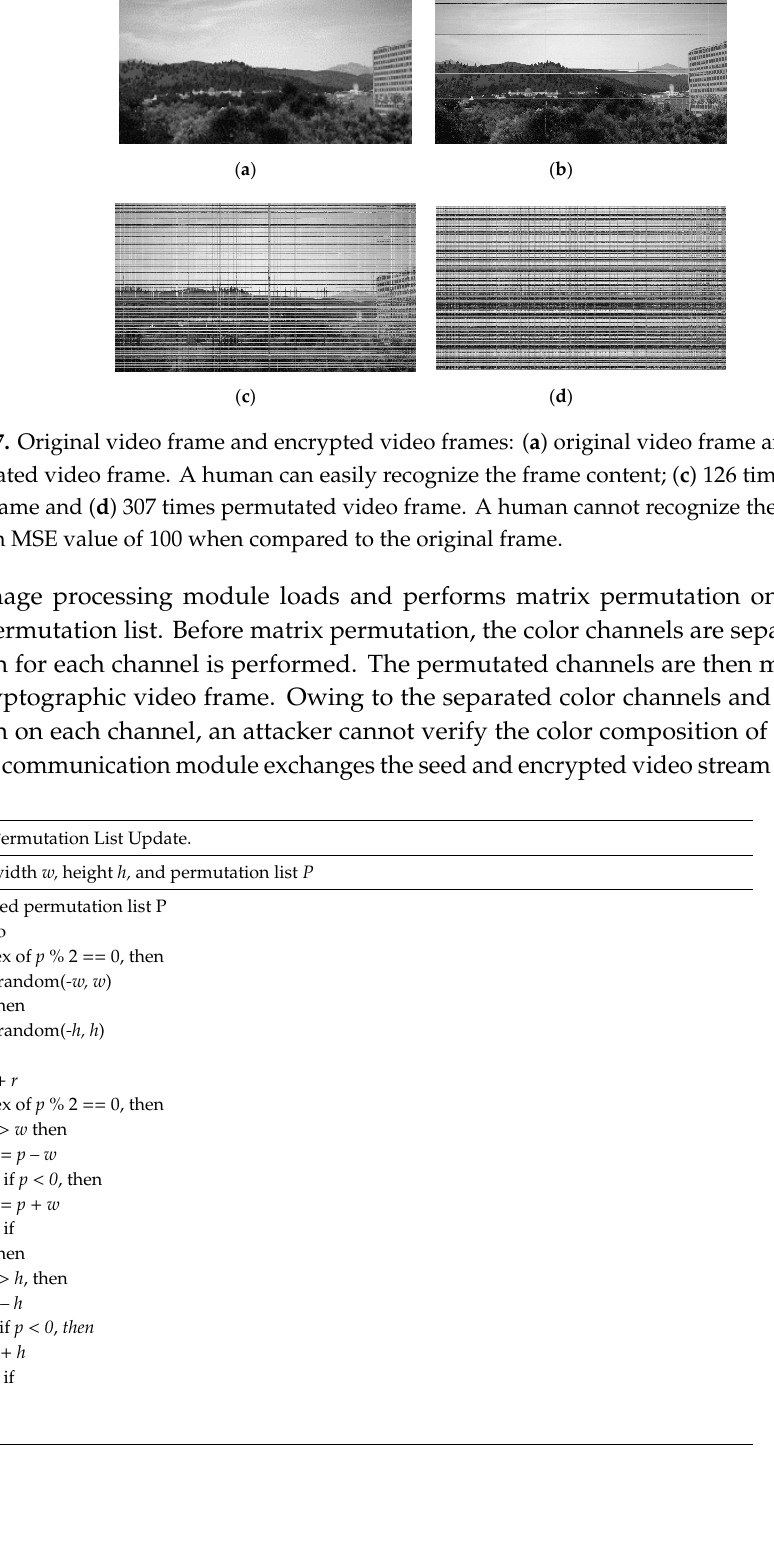
Figure 6. Permutation list management module structure and flows.